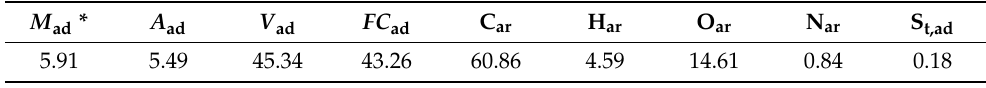
Table 2. Proximate analysis and element analysis of lignite as a